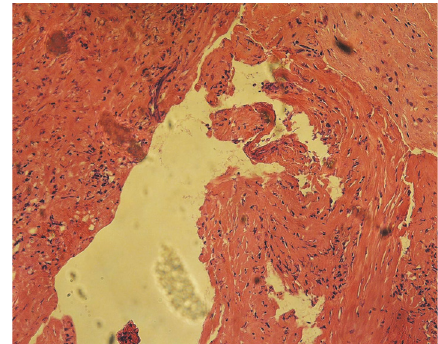
Figure 2: Intraoperative photograph showing the ganglion cyst of the ligamentum